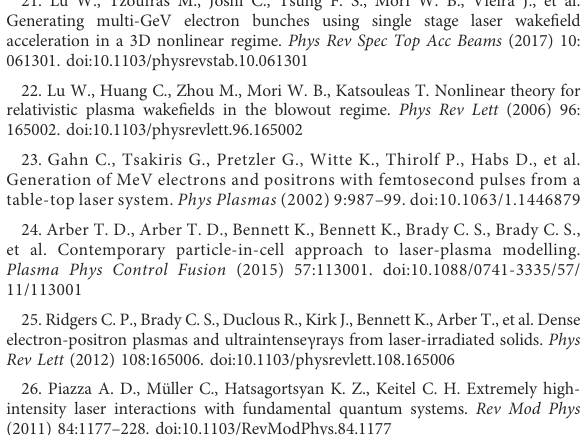
table-top laser system. Phys Plasmas (2002) 9:987 – 99.